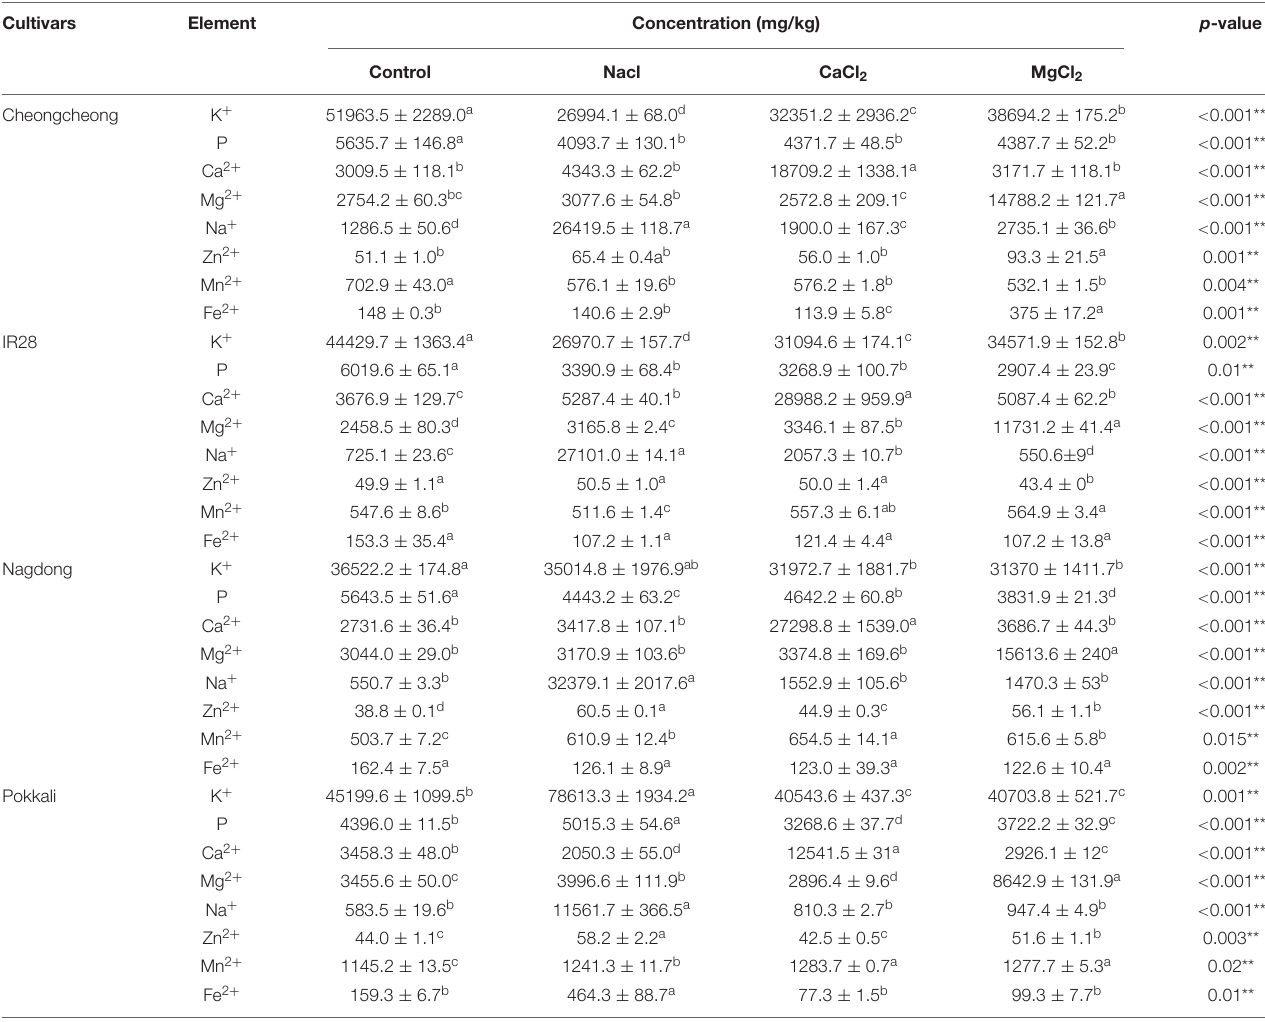
TABLE 3 | Effects of different salt stress on nutrients uptake in soil among rice cultivar shoots. Cultivars